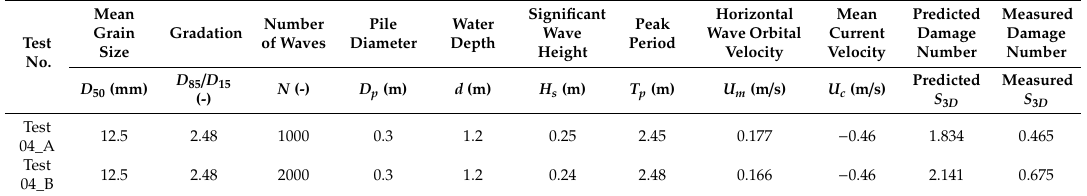
Table 10. Measured and predicted S3D number for Test 04_A and